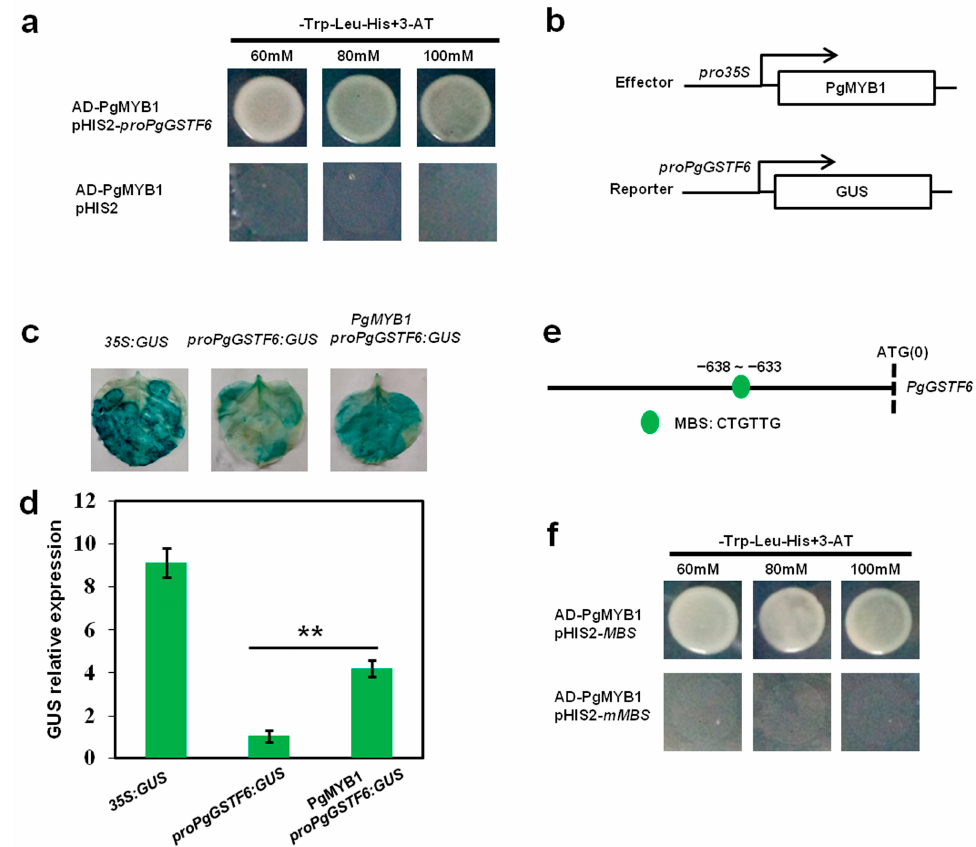
Figure 5. PgMYB1 directly regulates PgGSTF6 transcription. ( a ) Yeast-one-hybrid assays showed that PgMYB1 binds to the PgGSTF6 gene promoter. Positive colonies were screened on SD/-Trp-Leu-His medium containing optimal concentrations of 60 mM, 80 mM, and 100 mM 3-AT. ( b ) The 35S:PgMYB1 effector construct and the proPgGSTF6:GUS reporter construct were used for activity assays. ( c ) The PgMYB1 plus proPgGSTF6:GUS leaves showed significantly higher GUS activity. ( d ) qRT-PCR showed a higher GUS expression level in PgMYB1 plus proPgGSTF6:GUS tobacco leaves than in proPgGSTF6:GUS leaves. qRT-PCR was conducted in three biological replicates and three technical replicates, and one representative biological repeat is shown. ** p -values < 0.01 were considered statistically significant. ( e ) The location of the MBS (CTGTTG) motif on the PgGSTF6 gene promoter. ( f ) Yeast-one-hybrid assays showed that PgMYB1 binds to the MBS (CTGTTG) motif of the PgGSTF6 gene promoter, but not to the mMBS (CGGTGG). Positive colonies were screened on SD/-Trp-Leu-His medium containing optimal concentrations of 60 mM, 80 mM, and 100 mM 3-AT.